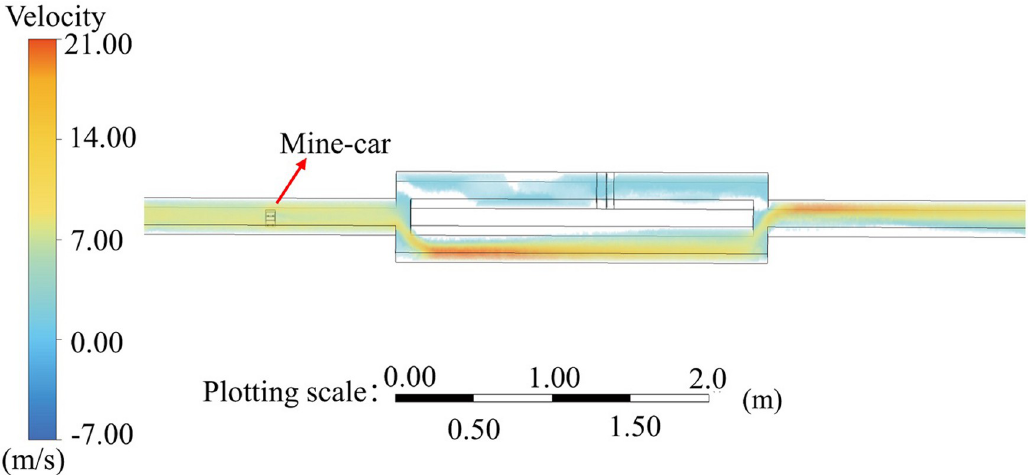
Fig 5. Experimental-model numerical simulation parameters and flow-field distribution for 7.90-m/s inlet wind